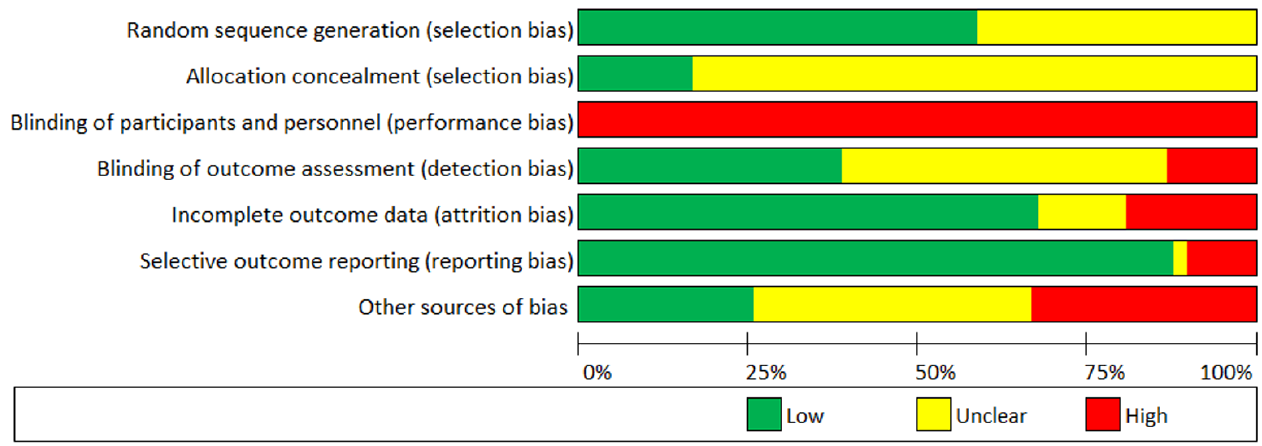
Figure 3. Risk of bias chart of studies included in the quantitative analysis.